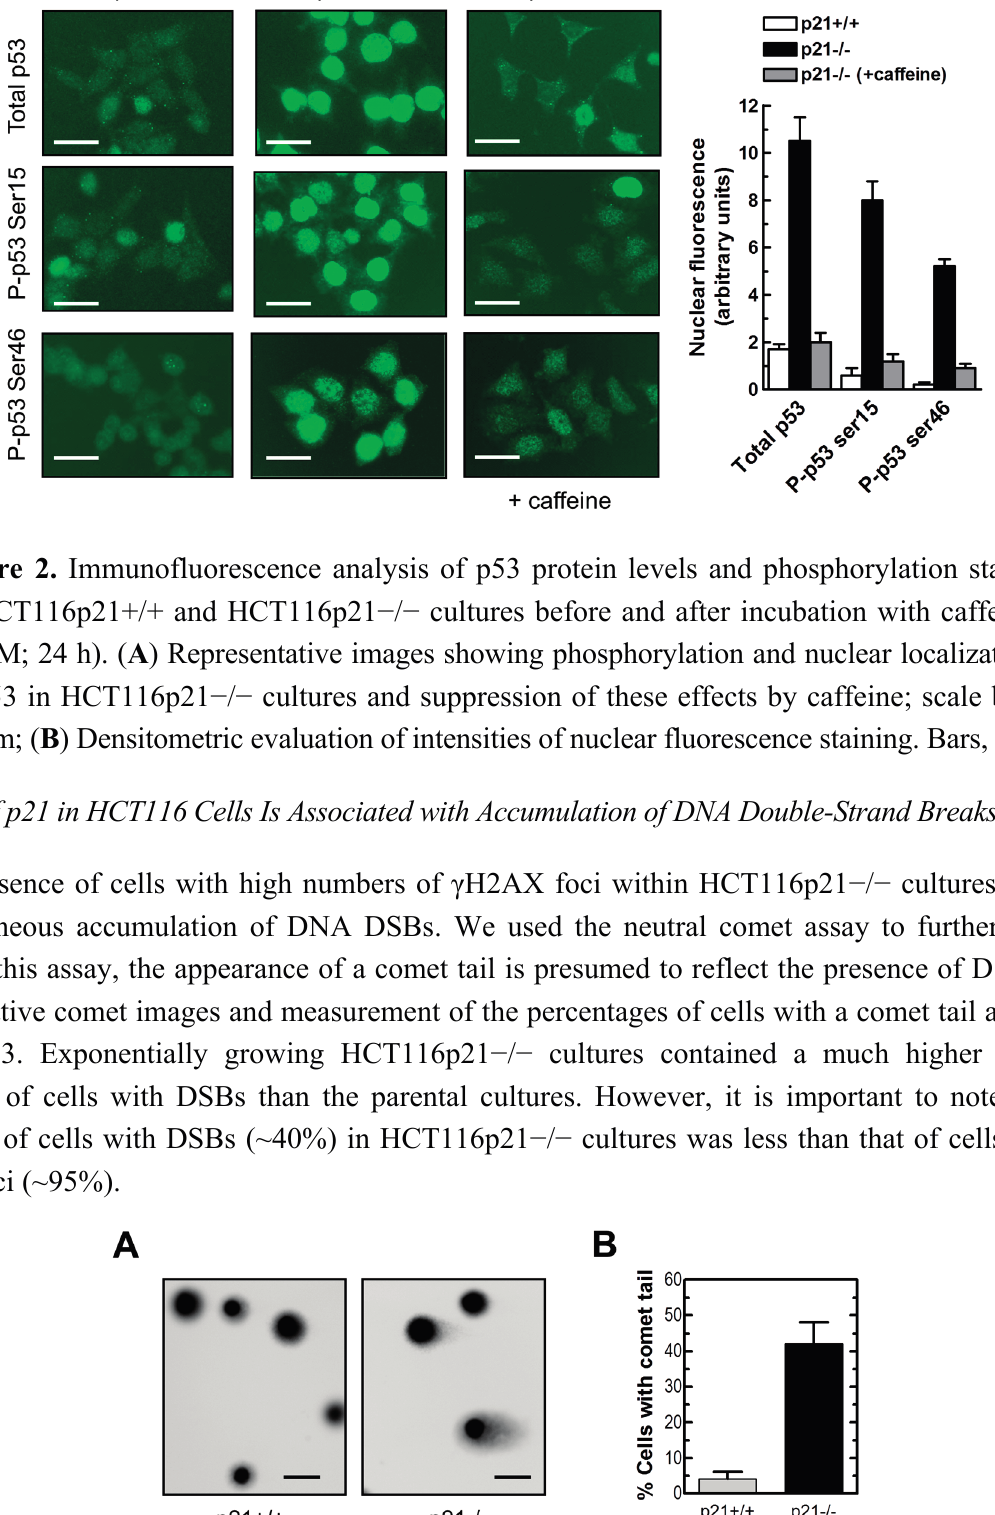
Figure 3. Neutral comet analysis of DSBs in HCT116p21+/+ and HCT116p21 − / − cultures. Representative images ( A ) together with percentages of cells with DSBs ( B ) are presented. The mean (± SE) of the values obtained for four comet slides are shown in panel ( B ); at least 50 cells were analyzed for each slide. Scale bar, 10